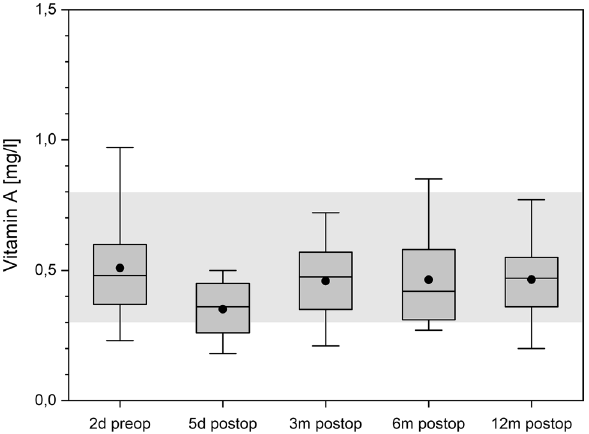
Figure 8. Vitamin A over time. The boxes contain the 25% and the 75% quartile as well as the median, black dots depict the mean, and whiskers range from the 5% percentile to the 95% percentile. Gray areas depict the normal range for each